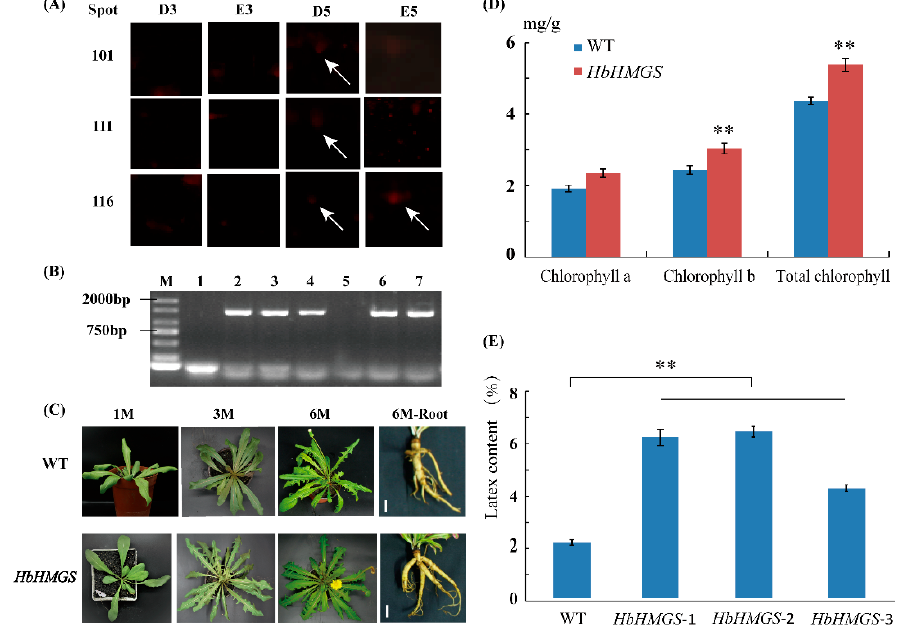
Figure 6. Functional analysis of HbHMGS2 in the rubber grass Taraxacum Kok-saghyz . The protein spots identified as HMGS2 in the 2-DE gels are highlighted, the white arrows indicate the detail location of the corresponding spots that identified as HMGS2 ( A ). The target gene in di ff erent transgenic rubber grass lines was determined ( B ) and phenotypes of the transgenic and wild type (WT) plants grown for 1 (1M), 3 (3M) and 6 (6M) months in a greenhouse are presented ( C ). The photosynthetic pigment content in the 6M-old leaves of the transgenic rubber grass and WT plants was determined, and the results proved that the over-expressing of HbHMGS can significantly improve the chlorophyll content in the leaves of rubber grass ( D ). The natural rubber content in the 6M roots of wild type and transgenic plants was determined from three independent lines ( E ). Double asterisks indicate the significant di ff erence among di ff erent samples.